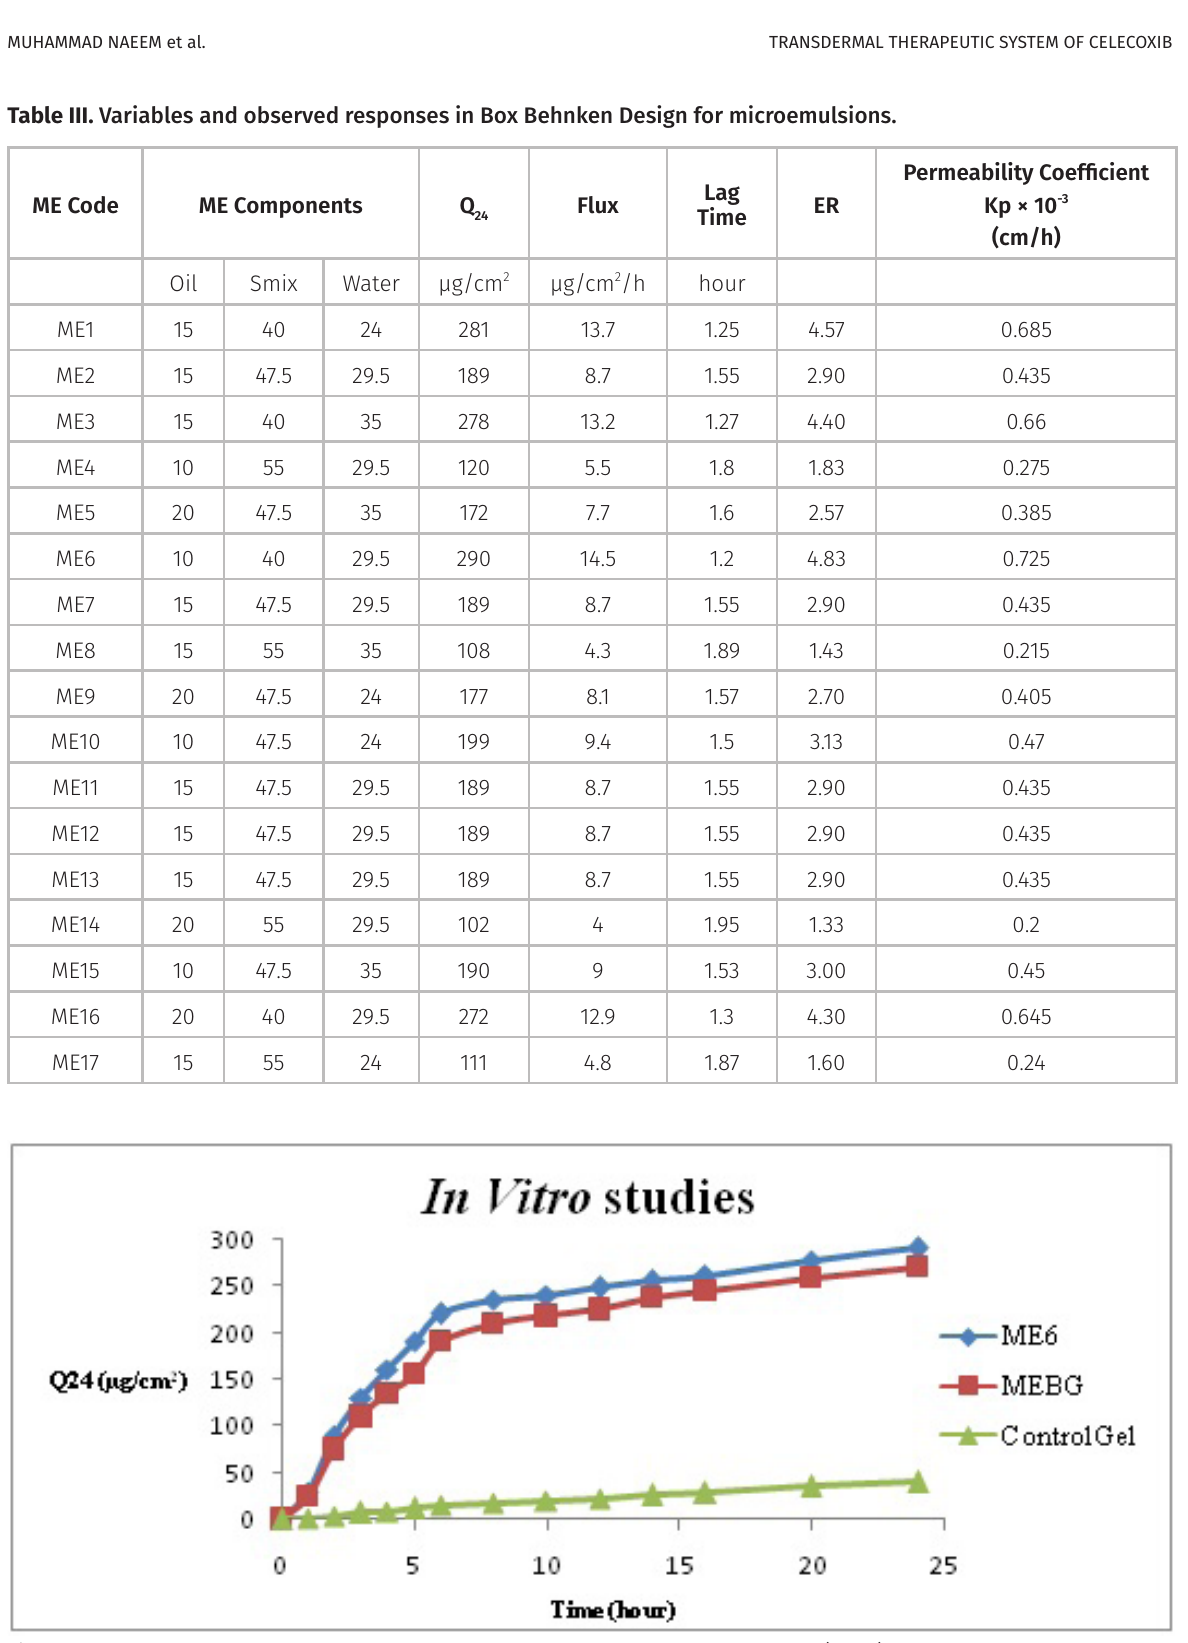
, MEBG and control (n = 6